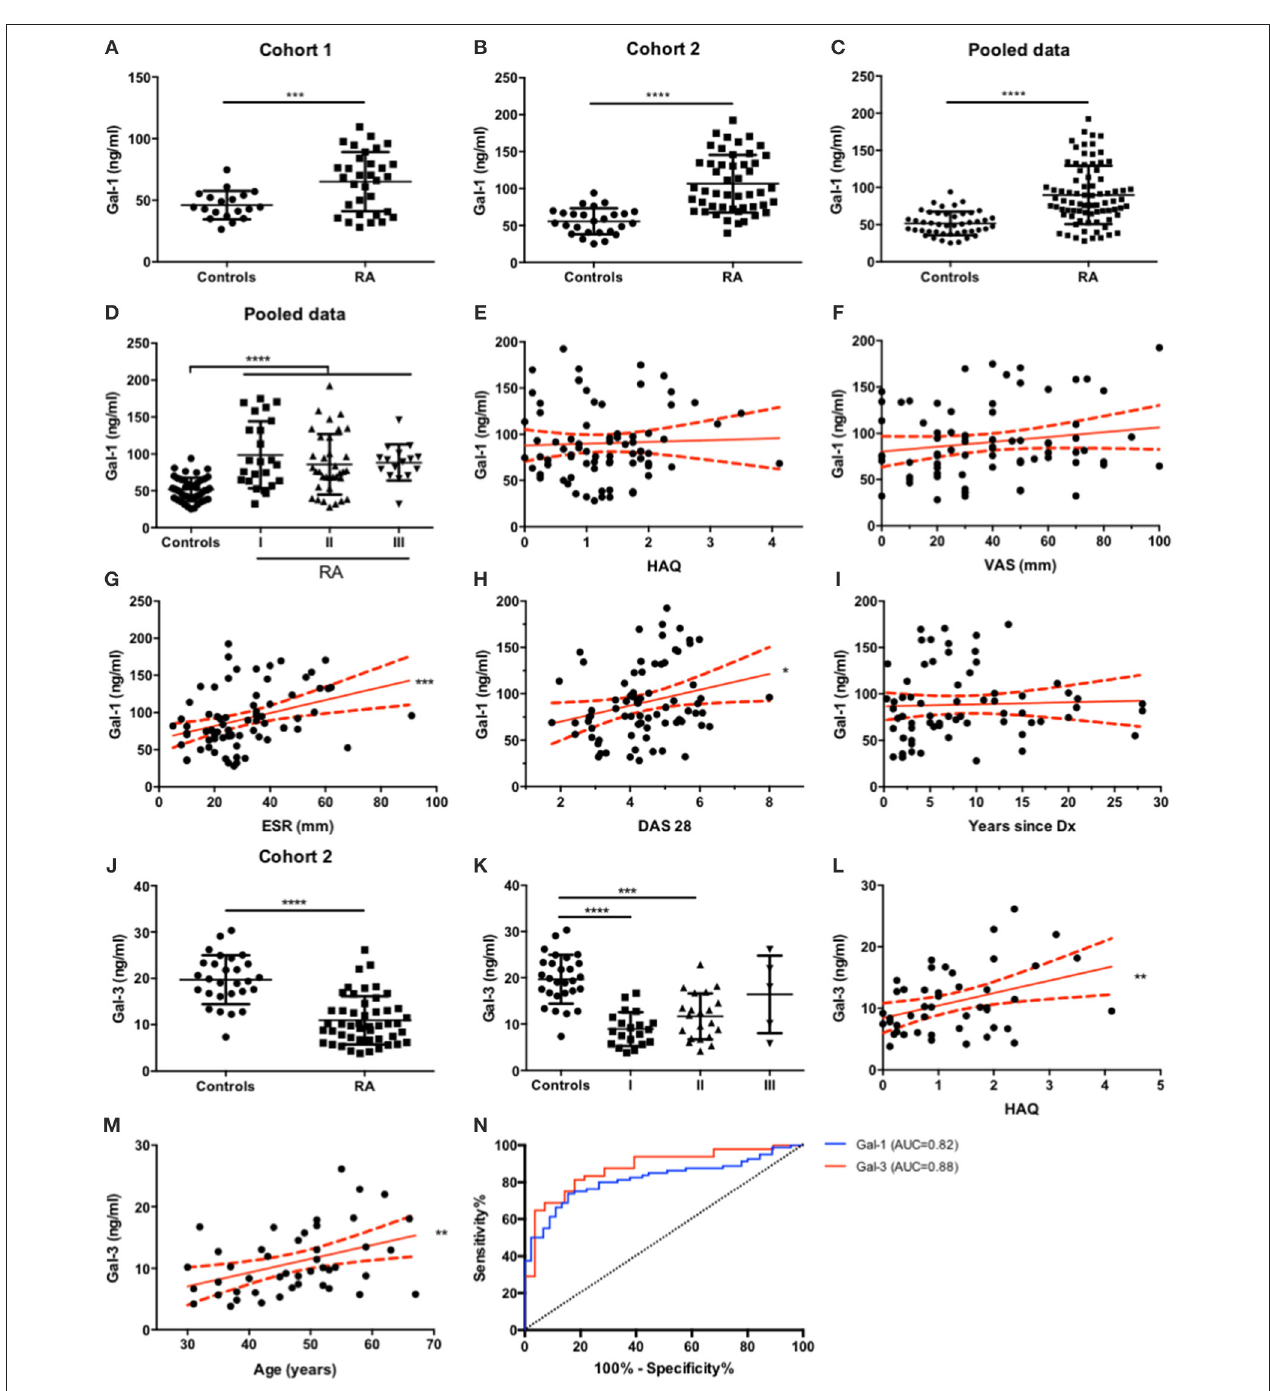
FIGURE 2 | Serum Gal-1 and Gal-3 expression levels discriminate RA patients from healthy individuals. (A-C) . Determination of serum Gal-1 levels (ELISA) in controls and RA patients from cohort 1 (A) , cohort 2 (B) and pooled data (C) . (D) . Gal-1 serum levels from all patients (C) classified by functional status. (E-I) . Correlation analysis of Gal-1 serum levels of all patients with HAQ (E) , VAS (F) , ESR (G) , DAS-28 (H) and RA duration (I) . (J) . Determination of serum Gal-3 levels (ELISA) in controls and RA patients from cohort 2. (K) . Gal-3 serum levels of RA patients from cohort 2 (J) classified by functional status. (L-M) . Correlation analysis of Gal-3 serum levels of RA patients from cohort 2 with HAQ (L) and age (M) . (N) . ROC curve analysis to assess Gal-1 (blue) and Gal-3 (red) capacity to discriminate between RA patients and healthy individuals. * p < 0.05, ** p < 0.01, *** p < 0.001. **** p < 0.0001. All variables analyzed were tested for Gaussian distribution with D’Agostino and Pearson omnibus normality test. For comparisons between two groups, unpaired t test with Welch’s correction or Mann-Whitney tests were applied as appropriate. For comparisons between more than two groups, Kruskal-Wallis test was applied. For correlation analysis, Pearson or Spearman correlation tests were applied as appropriate. To determine the capability of Gal-1 and Gal-3 serum level measurements to discriminate between RA patients and controls, ROC curves were generated.